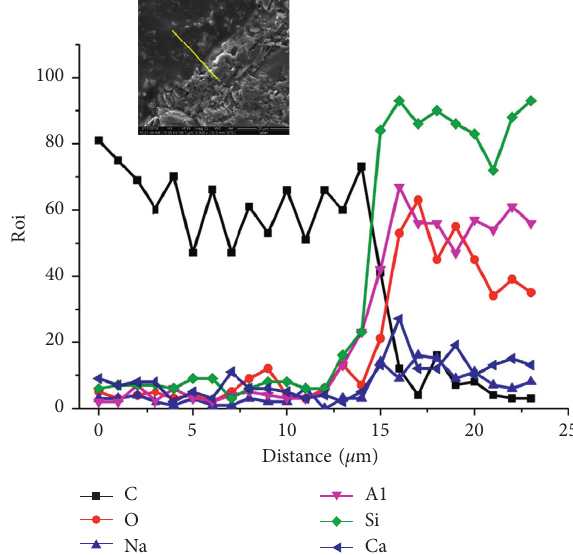
Figure 16: Element sweep analysis result of the SFP interface.